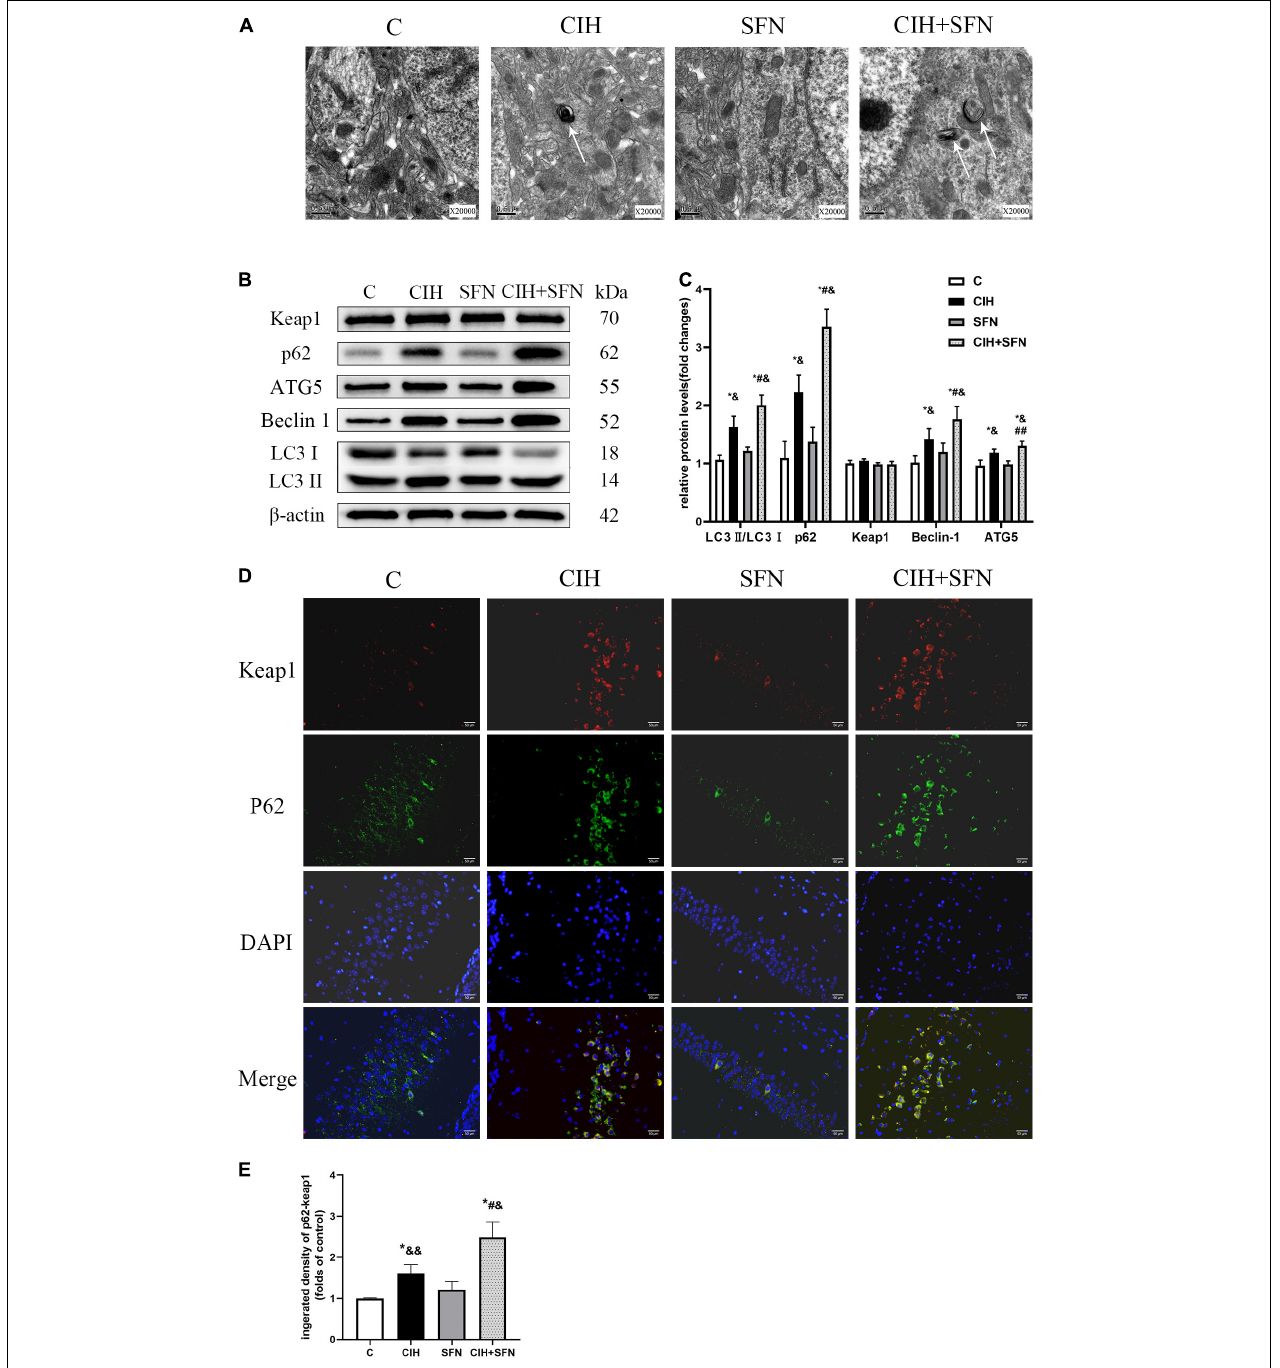
FIGURE 5 | SFN modulates autophagy induced by CIH. (A) Transmission electron microscope reveals autophagosomes (white arrows) in hippocampal neurons. Scale bar, 0.5 µ m. Magnification × 20,000. (B,C) Representative immunoblots and analysis of Beclin1, ATG5, LC3 II, LC3 I, p62, and Keap1 in each group from the hippocampus. (D,E) Representative images of p62 (green) and Keap1 (red) colocalization in hippocampal CA1 region with or without SFN treatment. Scale bar, 50 µ m. n = 5, * p ≤ 0.01 vs. C; ** p ≤ 0.05 vs. C; # p ≤ 0.01 vs. CIH; ## p ≤ 0.05 vs. CIH; & p ≤ 0.01 vs. SFN; && p ≤ 0.05 vs.